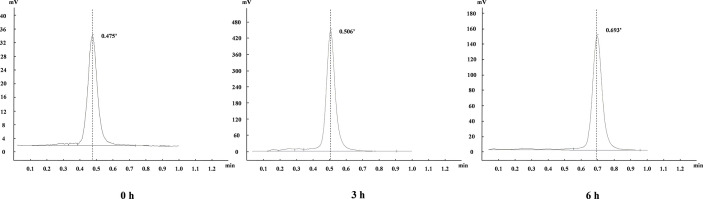
Radiochemical purities determined by iTLC-SG at 0, 3 and 6 h.